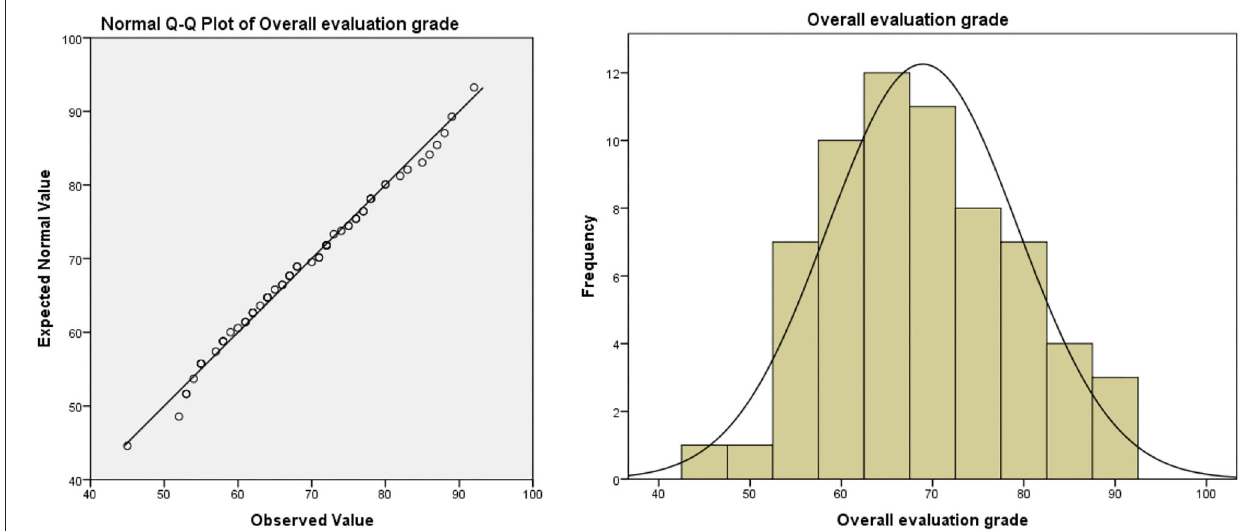
FIGURE 7 | Overall evaluation grade of an online-offline teaching